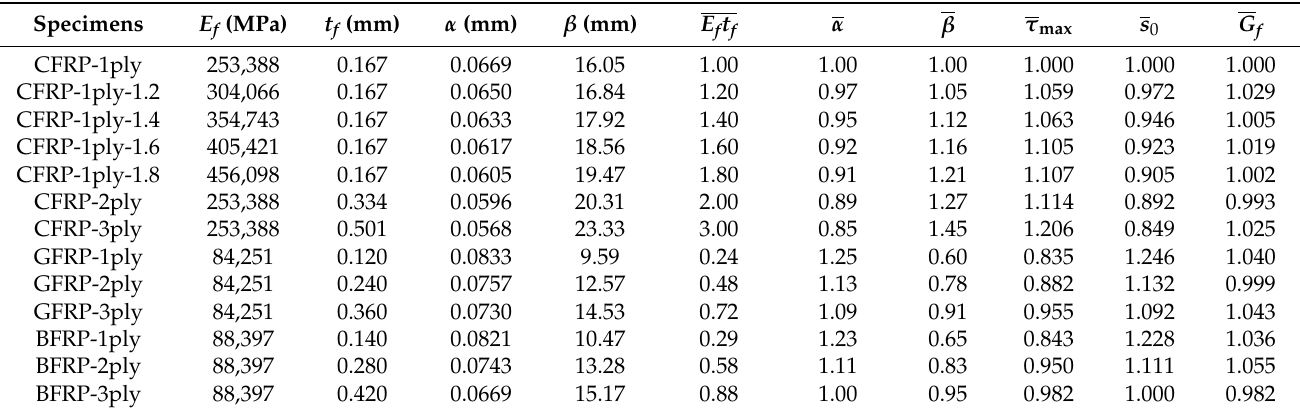
Table 4. Calculation results with different FRP